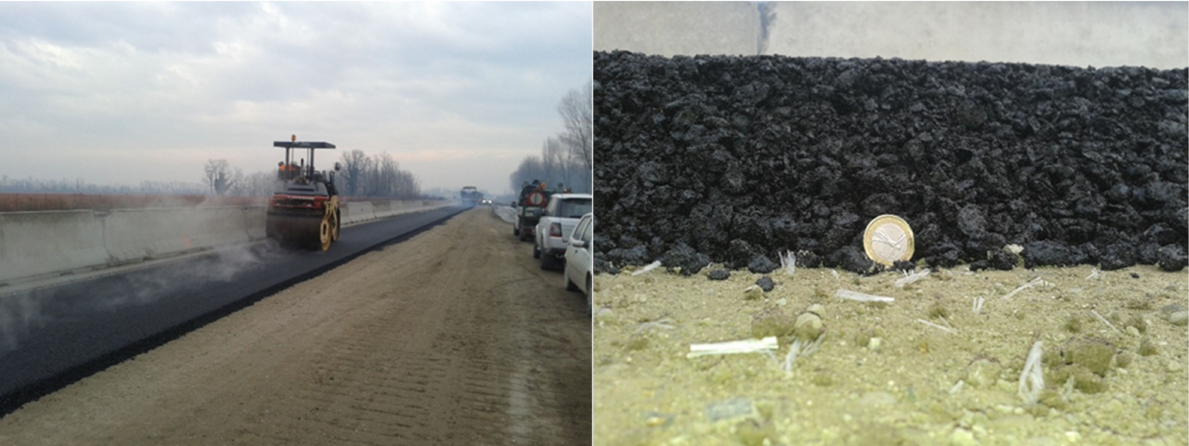
Figure 3. The installation of the base/binder course and its cross-section on polypropylene fiber- reinforced cement-mixed course. The scale coin is EUR 1; 23.25